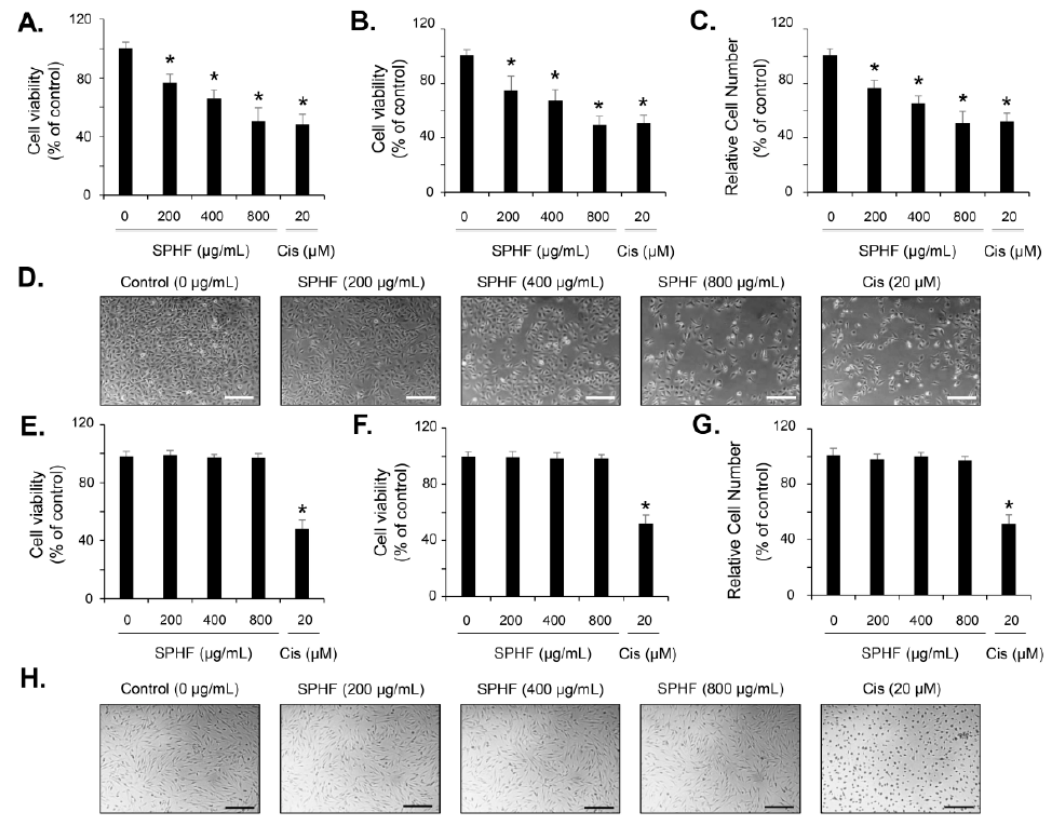
Figure 1. SPHF inhibited the proliferation of bladder cancer EJ cells. Both bladder cancer EJ cells and normal BdFC cells were treated with various concentrations of SPHF for 24 h. Both the MTT assay ( A , E ) and CCK-8 assay ( B , F ) were used to detect cell viability. ( C , G ) Cell numbers were counted via Trypan Blue staining. ( D , H ) Morphologic changes were photographed at the indicated SPHF treatment concentrations in EJ and BdFC cells (scale bars = 100 µ m). Cisplatin was used as a positive control ( A – H ). Values are presented as the mean ± SD of three independent experiments; * p < 0.05 relative to the non-treated group.